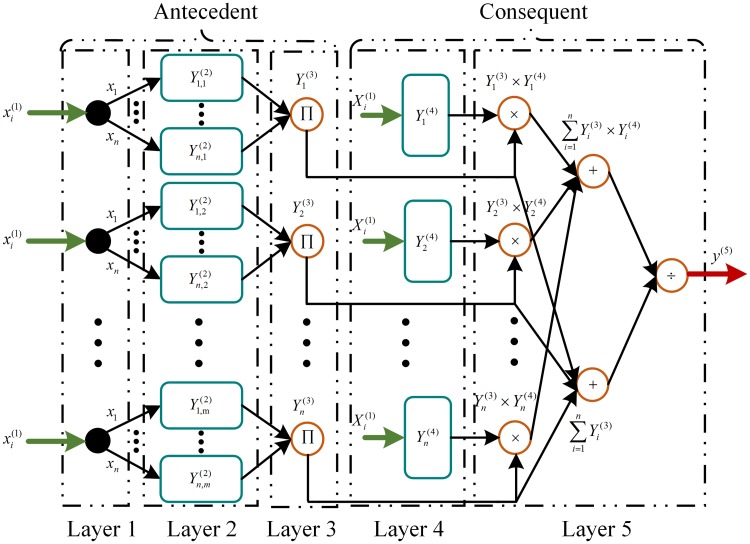
NeuroFuzzy network.